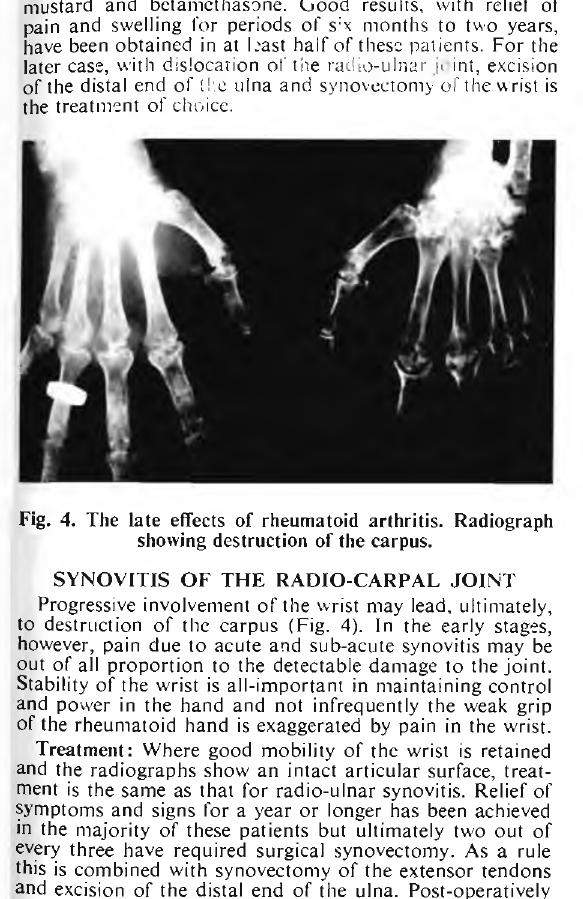
Fig. 3. Radial deviation of the wrist due to radio-ulnar synovitis.